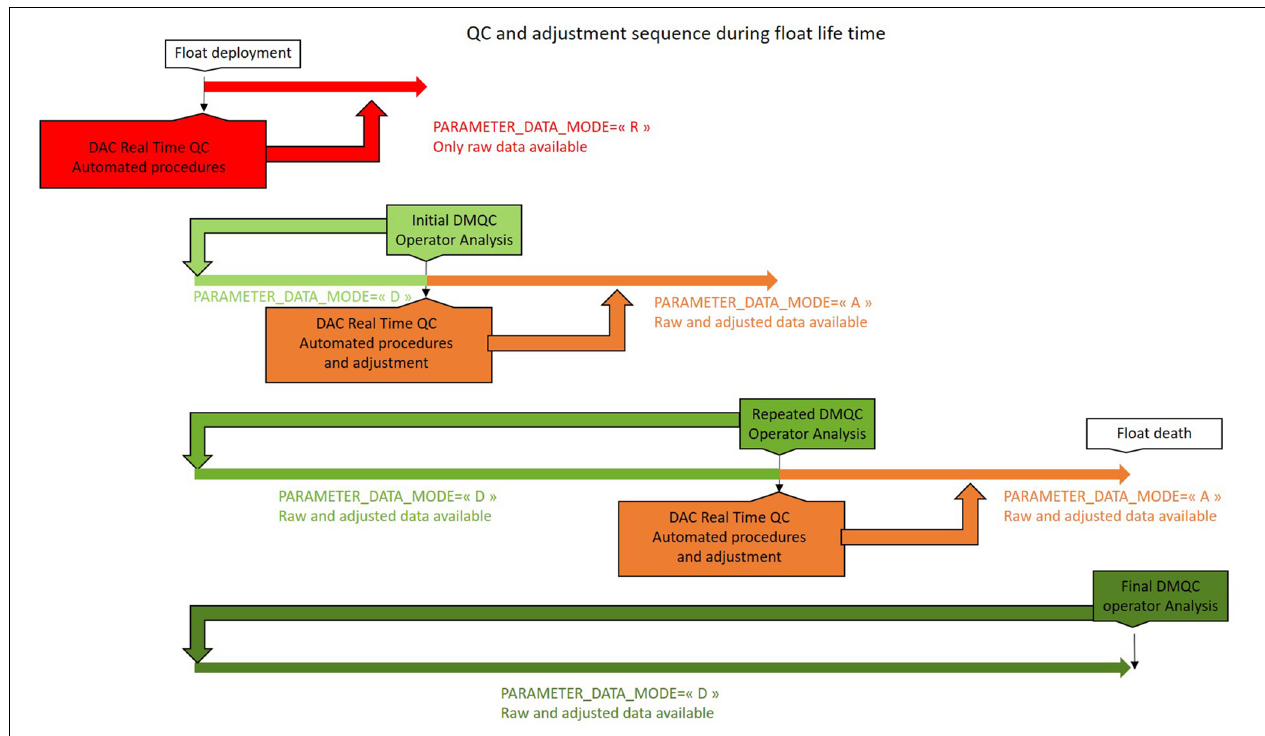
FIGURE 4 | Sequence of quality control and adjustment steps during the life time of a float from float deployment to death. The color shading indicates the data mode: “R” real-time data in red, “A” real-time adjusted data in yellow, and “D” delayed-mode data in green. Initial DMQC should be performed soon after deployment (typically after 5–10 cycles). With subsequent DMQC revisits (on an annual basis), adjustments become more reliable (indicated by the green shading).